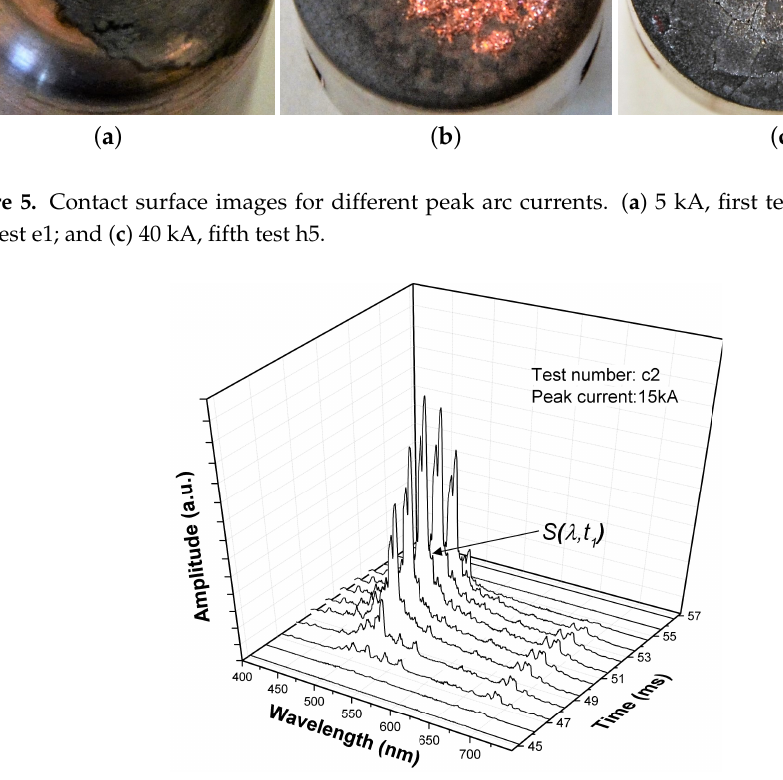
Figure 6. A typical time-resolved spectral signal (peak current 15 kA). Table 2. Strong emission lines of tungsten atom, copper atom and sulphur ion in a visible spectrum range